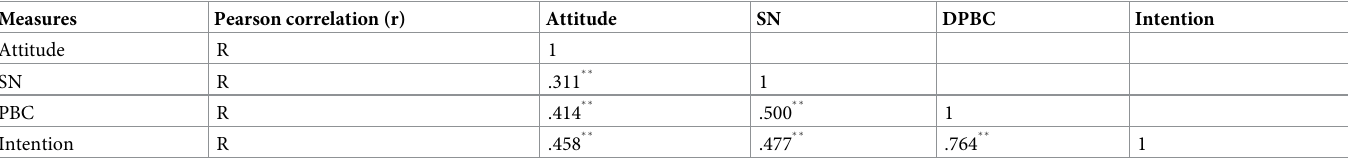
Table 6. Correlations between direct TPB constructs and intention to voluntary blood donation.